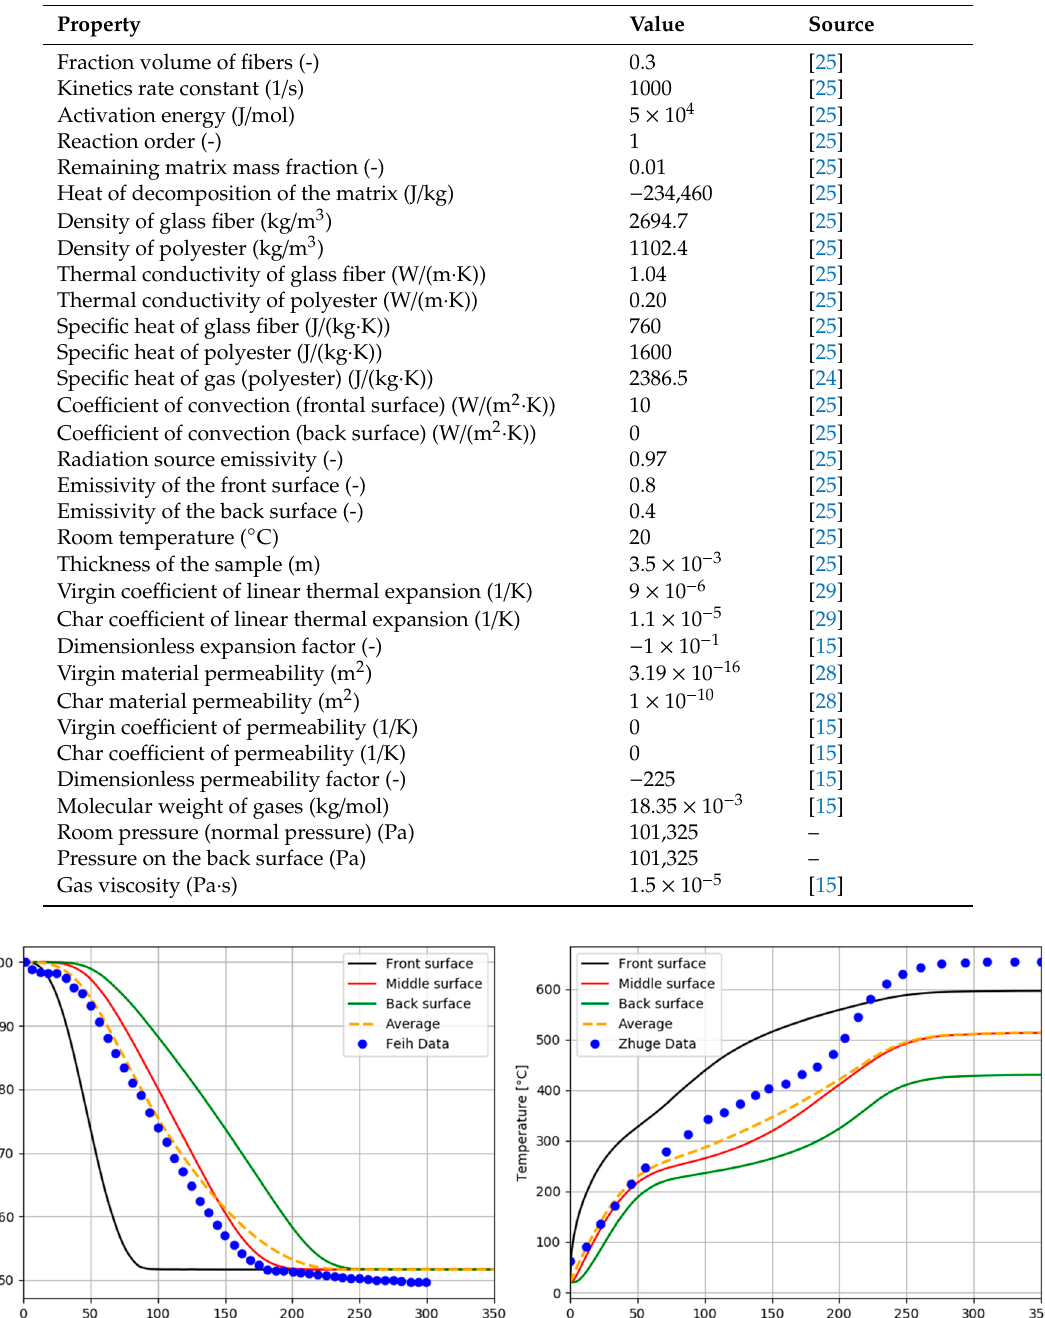
Table 2. Material properties for E-glass / polyester composite laminate.